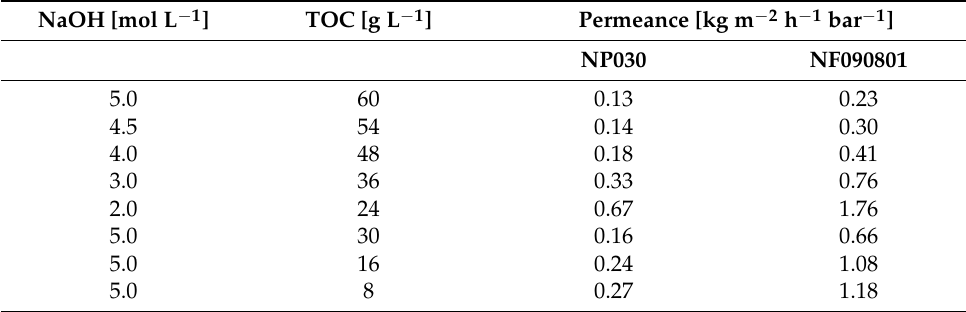
Table 5. Permeance of NP030 and NF090801 with Sol5 in various dilution